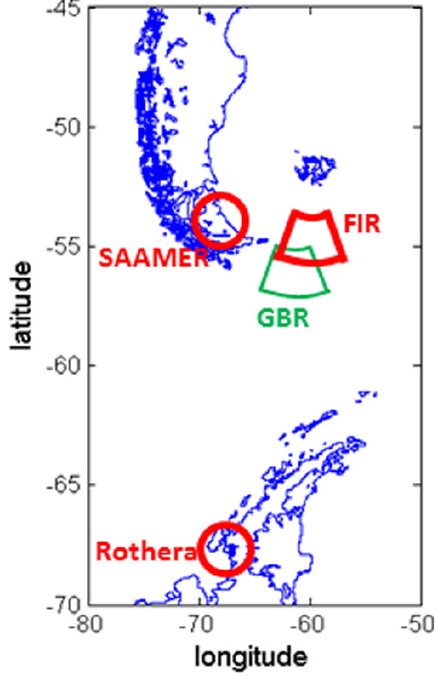
Fig. 1. Map showing the approximate field of view of the Falkland Islands SuperDARN radar (FIR) together with the SAAMER and Rothera radars referred to in the text. The green box labeled GBR represents the equivalent Northern Hemisphere field of view of the Goose Bay SuperDARN